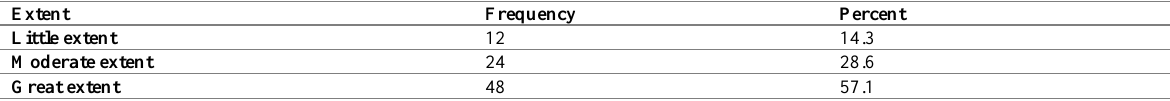
Table 7: Extent to which Church Has Embraced use of Modern